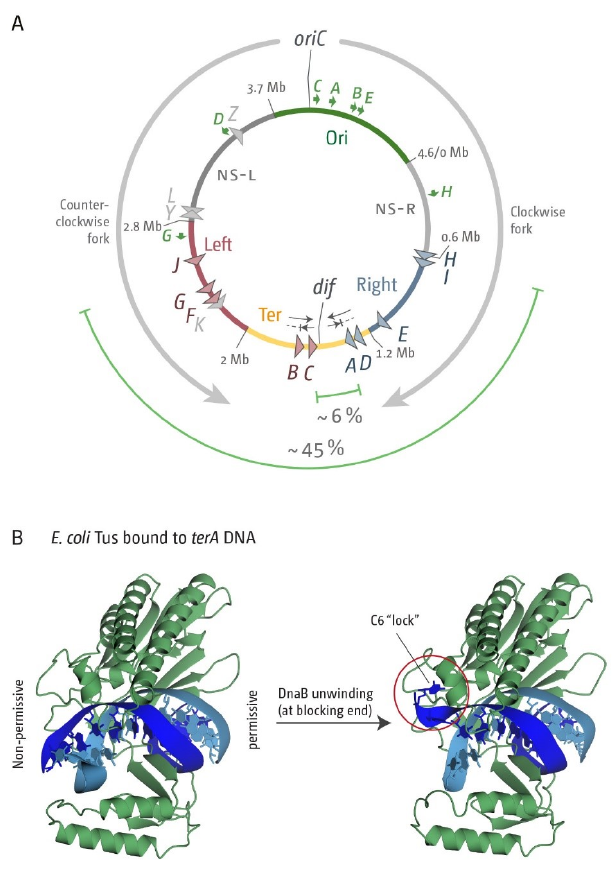
Figure 1. Chromosome structure and replication dynamics in Escherichia coli . ( A ) Schematic repre- sentation of the circular E. coli chromosome. Two replication forks are assembled at the origin ( oriC ) and move in opposite directions along the DNA (grey arrows) until they eventually approach one other and fuse within the terminus region diametrically opposite to oriC . A replication fork trap is formed in the terminus region via primary terminator sequences ( terA–J ). These are arranged as two opposed groups, with the red terminators oriented to block movement of the clockwise replication fork and the blue terminators oriented to block the anticlockwise fork. The total spanned fork trap area covered by ter sites, as well as the innermost termination area, are highlighted by green lines, with the fraction of the total genome size given in %. Secondary ter sites in the left-hand replichore with very low fork blocking activity [15] are shown in grey. Locations for oriC and the dif chromosome dimer resolution site are marked. The location of rrn operons, which are highly transcribed particularly under fast growth conditions, are shown by green arrows, with the arrow pointing in the direction of active transcription. Chromosomal macrodomains Ori, NS-R, NS-L, Right, Left and Ter are shown as described [7] and domain boundaries given in Mbp. ( B ) Crystal structure of the ter /Tus complex of E. coli indicating the blocking and permissive ends of the complex (left), and in the ‘locked’ conformation with DNA unwound at the blocking end and the C6 base of ter DNA bound to its specific binding pocket in Tus (right), which contributes significantly to the fork arrest activity of the